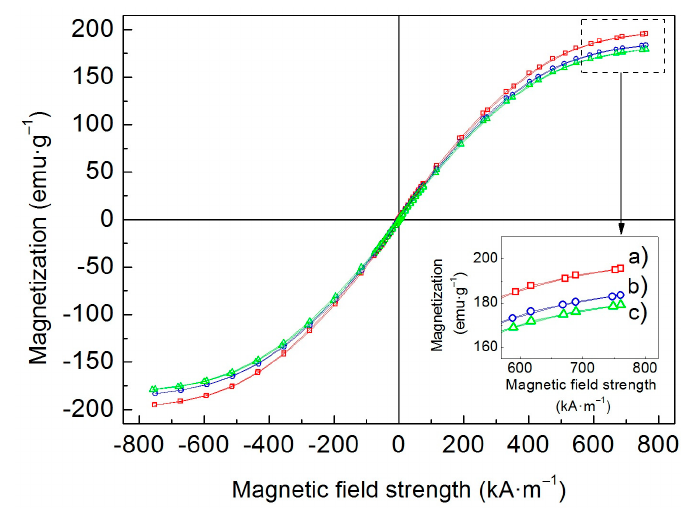
Figure 3. Magnetization curves of ( a ) bare CI, ( b ) CI- g -PHEMATMS-1, and ( c ) CI- g -PHEMATMS-2 particles obtained via VSM. The inset figure shows the data differences near the saturation magnetization.